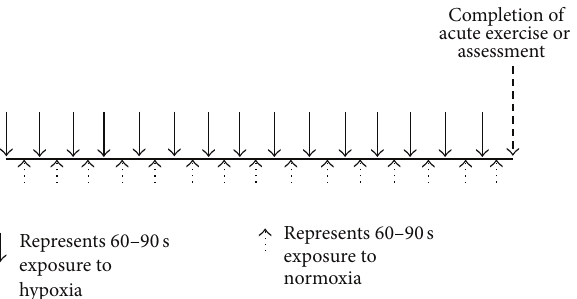
Figure 1: Schematic depicting the typical application of a single exposure to acute intermittent hypoxia preceding completion of exercise or an assessment in humans with SCI. Blood pressure, heart rate, and oxygen-hemoglobin saturation are continually monitored during this application to ensure normal responses to